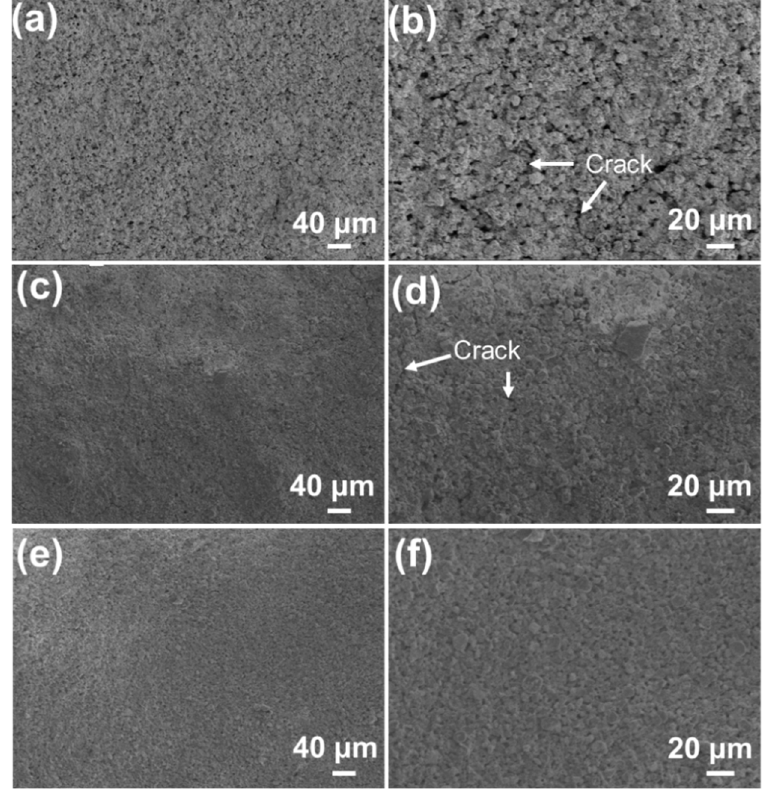
Figure 2. SEM images of the surface sections of the SiOC/Al 2 O 3 /YSZ coatings with different mass fractions of Al 2 O 3 and YSZ: ( a , b ) 68 wt.%, ( c , d ) 75 wt.%, ( e , f ) 79 wt.%.